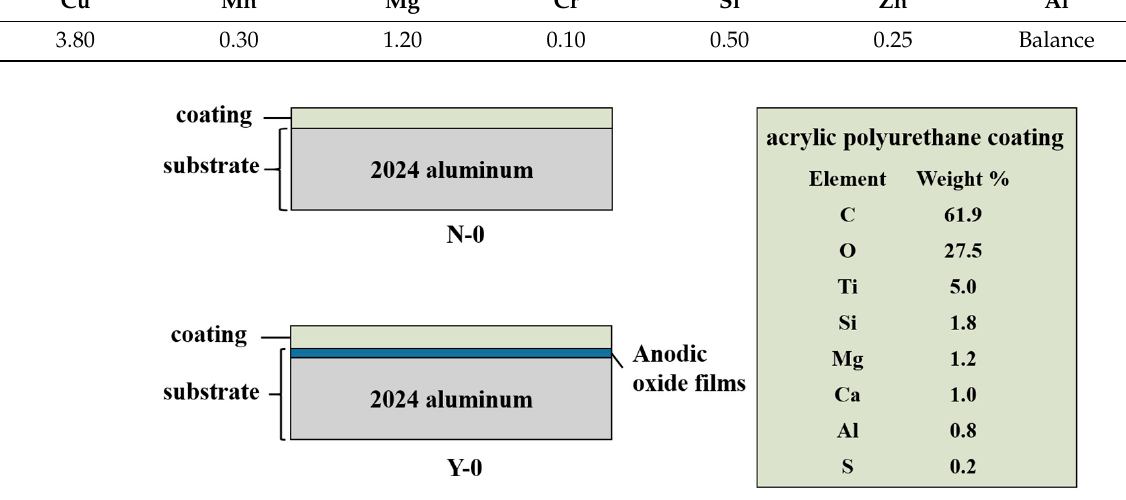
Figure 1. Sectional view of the specimens and elemental composition of superficial acrylic polyurethane coatings.